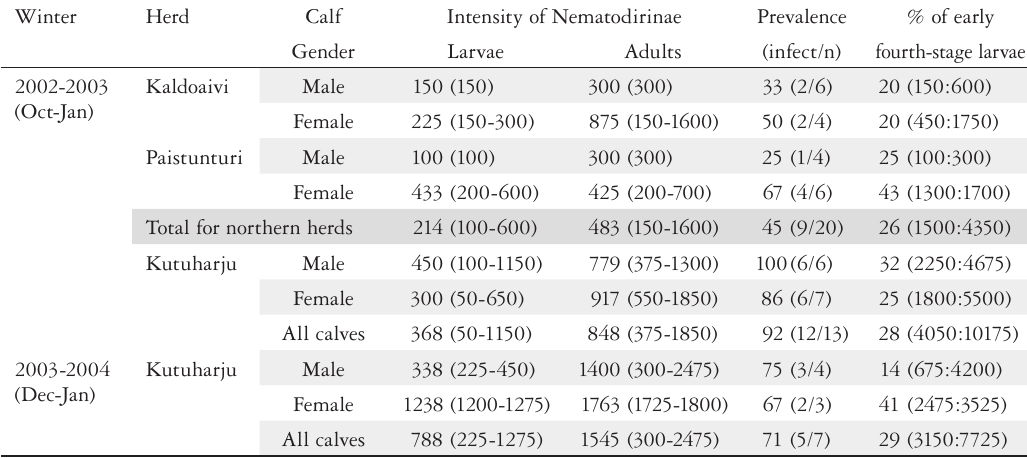
Table 3. Infection of Nematodirinae nematodes in reindeer calves. Mean intensity (range in parenthesis), prevalence (% infected), and percentage of nematodes found in the early fourth-stage of larval development (number of larvae and adults in parenthesis) of the small intestine.